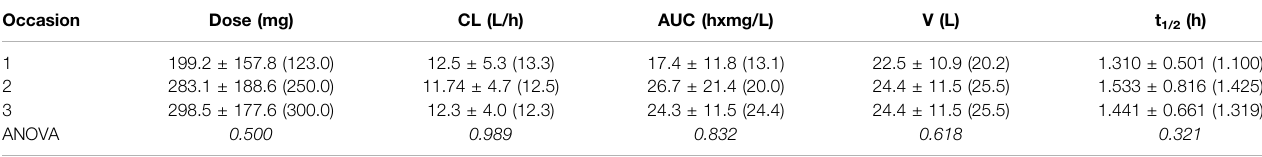
CL, systemic clearance; AUC, area under the time-concentration curve; V, volume of distribution; t 1/2 , terminal elimination half-life.